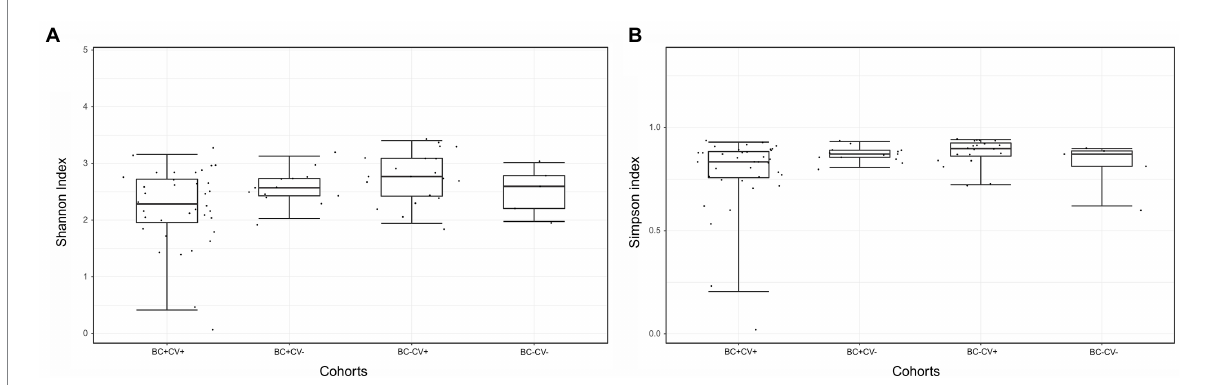
FIGURE 1 Comparison of alpha diversity estimates between the four groups of samples, based on (A) Shannon or (B) Simpson indexes. Comparisons were carried out with the Kruskal-Wallis (pairwise) test, no significant differences was found between groups.